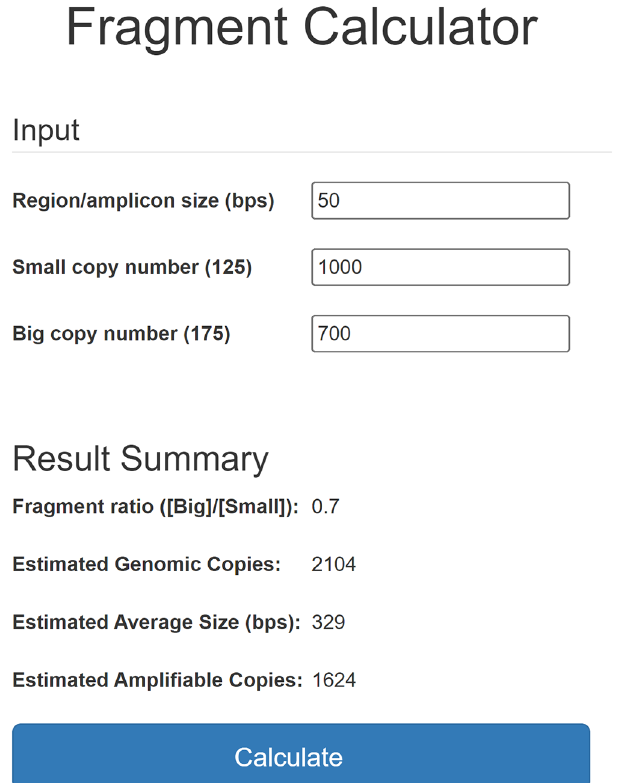
Figure 4. Fragment Calculator online tool with example inputs. The concentrations measured by the two amplicon sizes of our universal quantitative PCR 4-plex assay (125 bp and 175 bp) can be used to estimate the total concentration (i.e., the number of genomic copies), average fragment length of the sample, and the concentration of intact copies of any input region